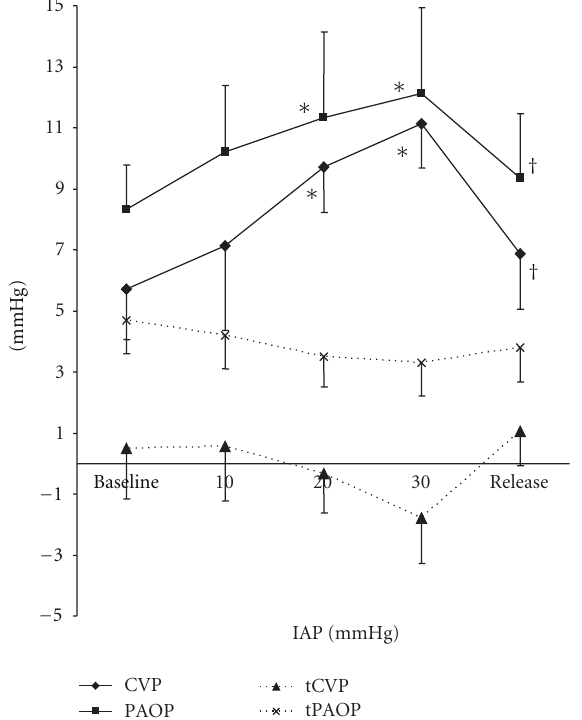
Figure 3: E ff ect of increasing intra-abdominal pressure (IAP) on central venous pressure (CVP), end-expiratory pulmonary artery occlusion pressure (PAOP) and transmural filling pressures (tCVP and tPAOP). Baseline = 6mmHg, release = 5mmHg. Data are expressed as mean ± SEM. ∗ P = 0 . 04 versus baseline, † P = 0 . 05 versus IAP =